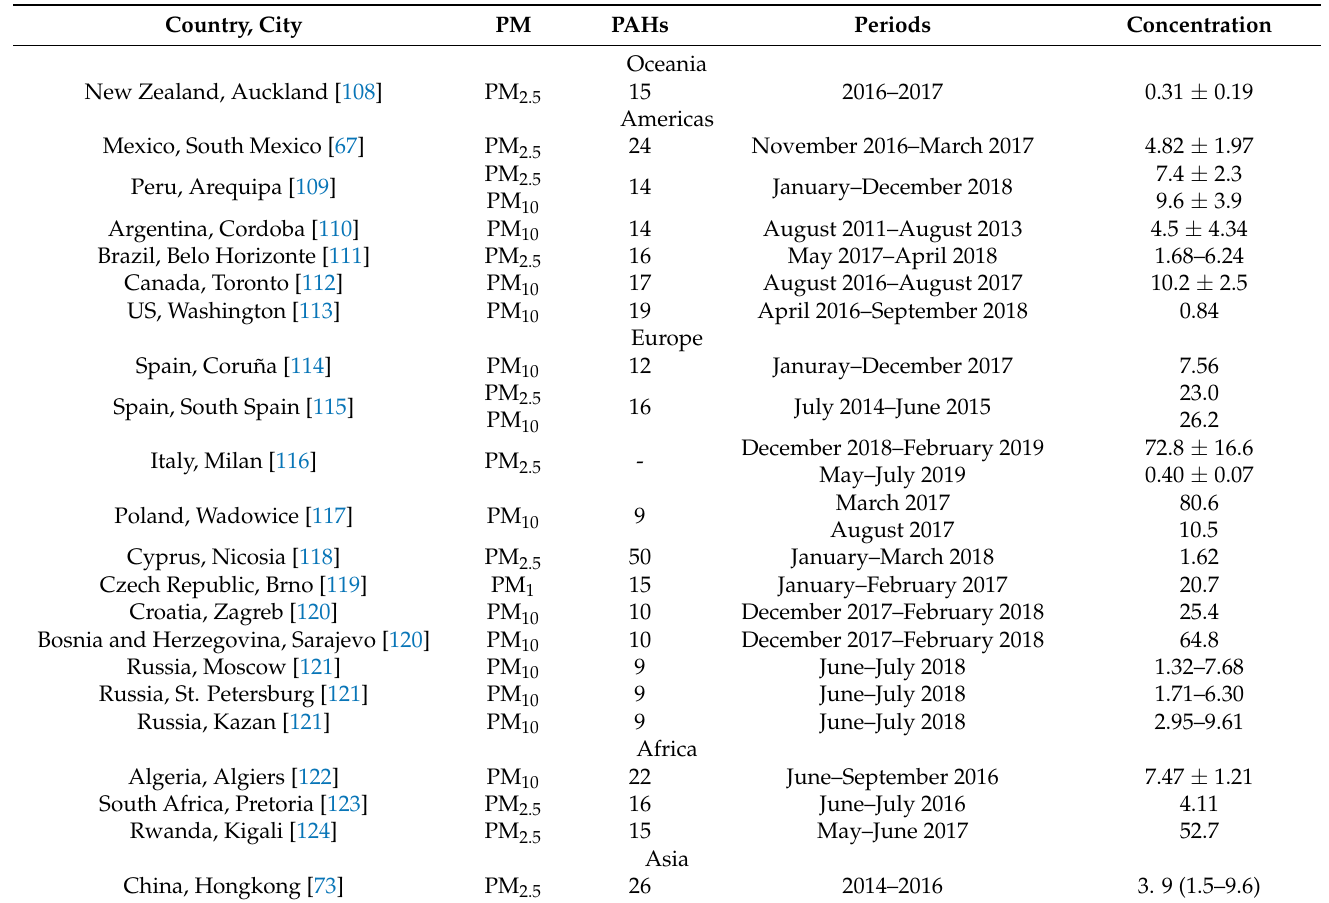
Rwanda, Kigali [124]